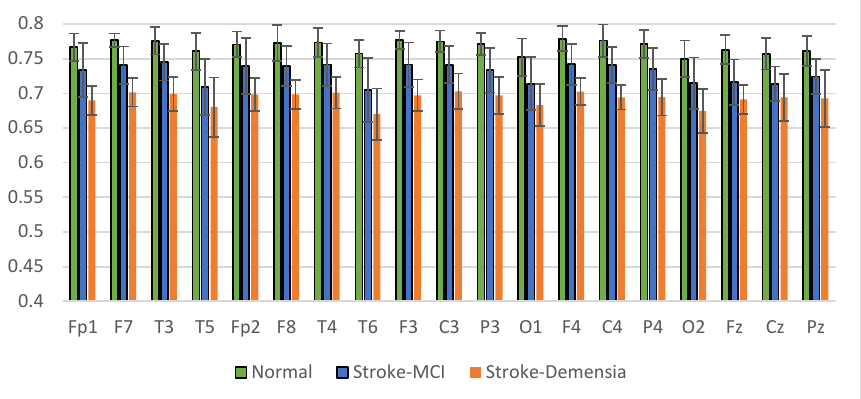
Figure 17. Mean of the SpecEn values of the normal, post-stroke MCI, and dementia.